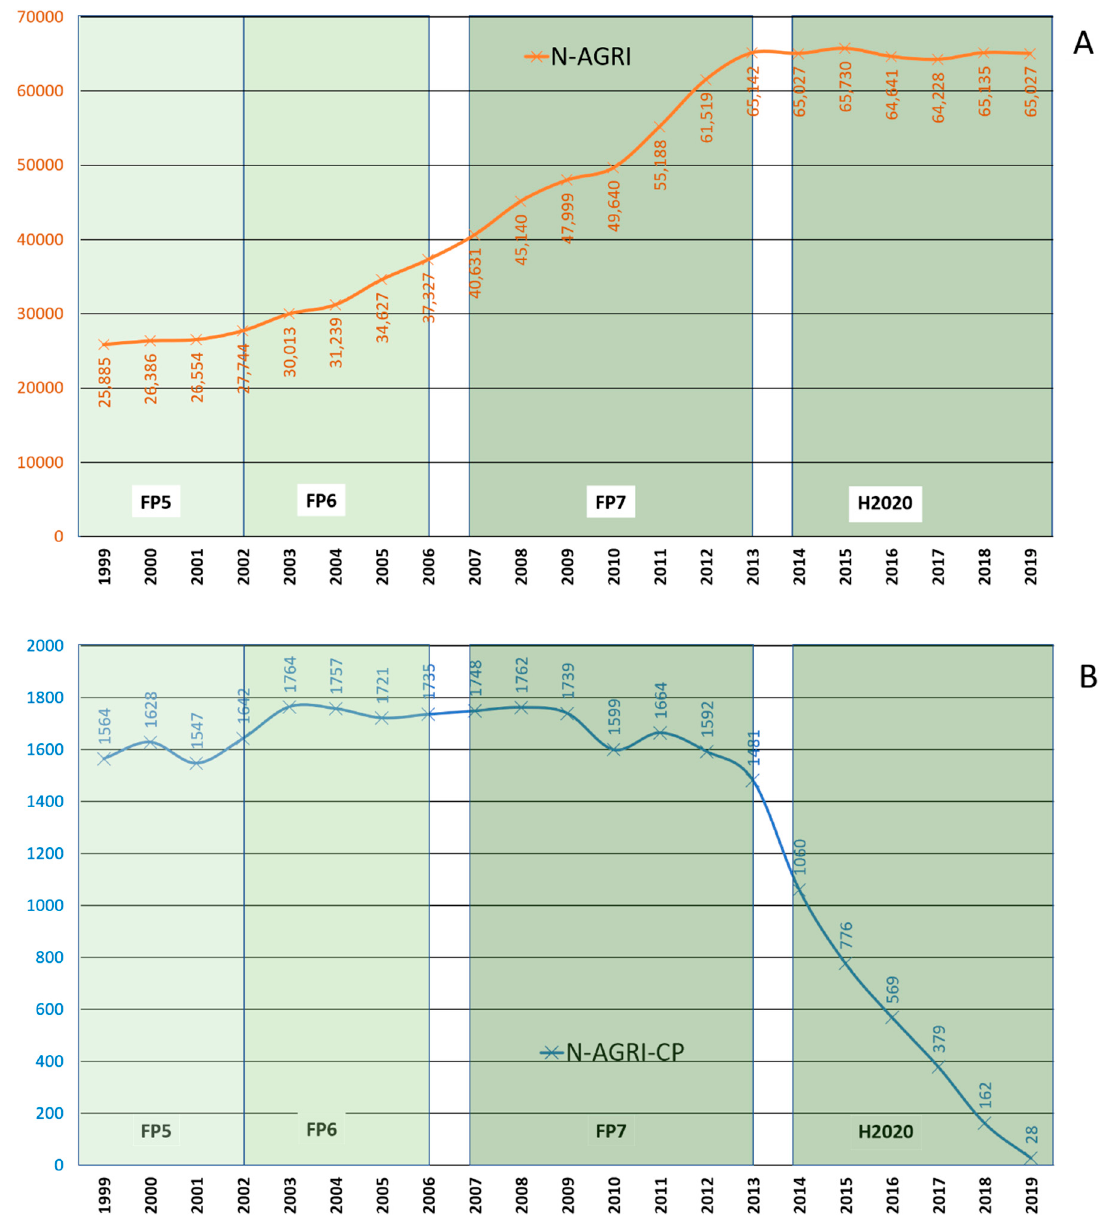
Figure 2. Agricultural and Biological Sciences publications: ( A ) total publication in Europe 27 (EU-27) (N-AGRI), ( B ) cited by international patents (N-AGRI-CP).